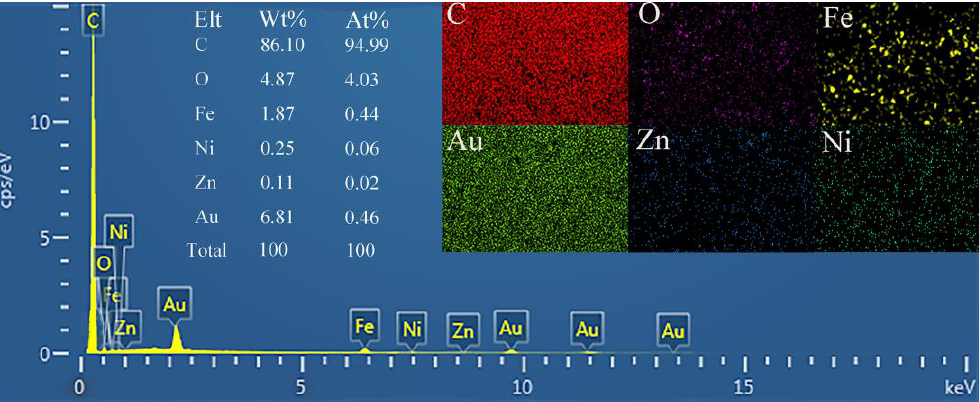
Figure 3. EDS spectrum of AuNPs/NiHCF-NPs/Zn/Fe-ZIF-NPC/GCE. Zn/Fe-ZIF loading volume: 8 μ L; Zn/Fe-ZIF-NPC loading volume: 8 μ L. CV cycle number of AuNPs electrodeposition: 10.